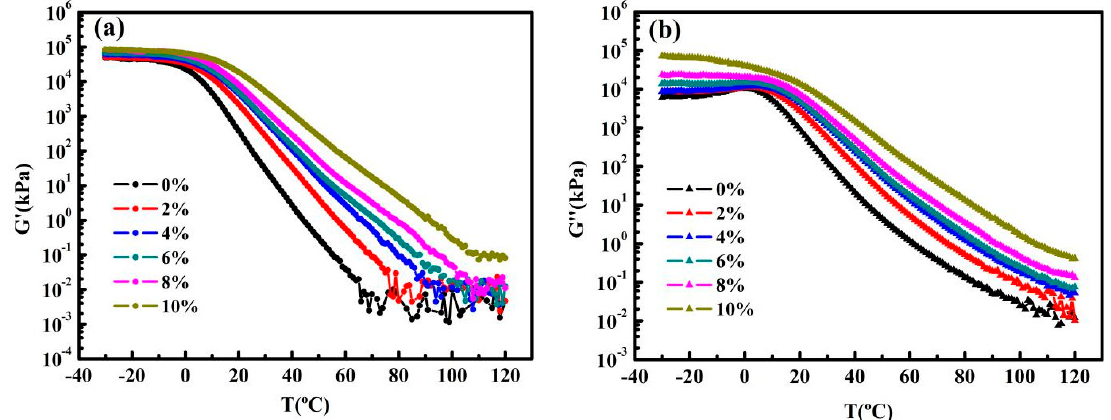
Figure 6. ( a ) Temperature sweeps results of control asphalt and GMAs (storage moduli versus temperature) at − 30–120 °C (PP25). ( b ) Temperature sweeps results of control asphalt and GMAs (loss moduli versus temperature) at − 30–120 °C (PP25).